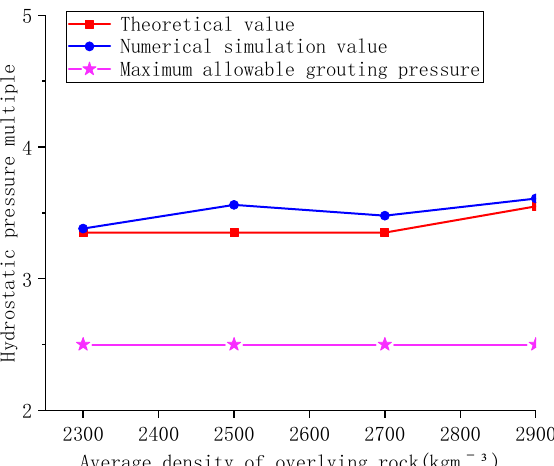
Figure 6. Comparison curve of fracture initiation grouting and hydrostatic pressures.